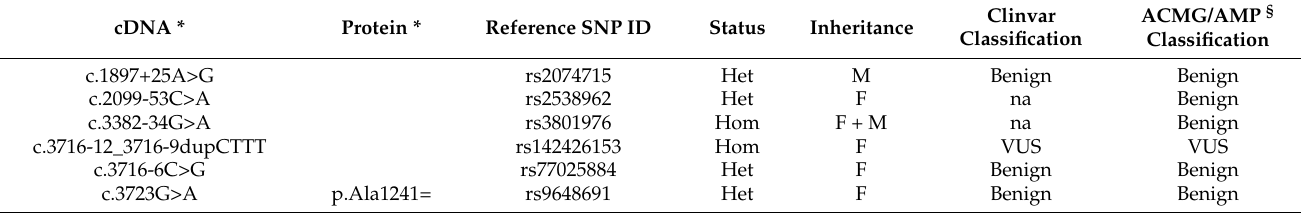
Table 2. DNA variants identified in the proband in the CNTNAP2 gene by exome